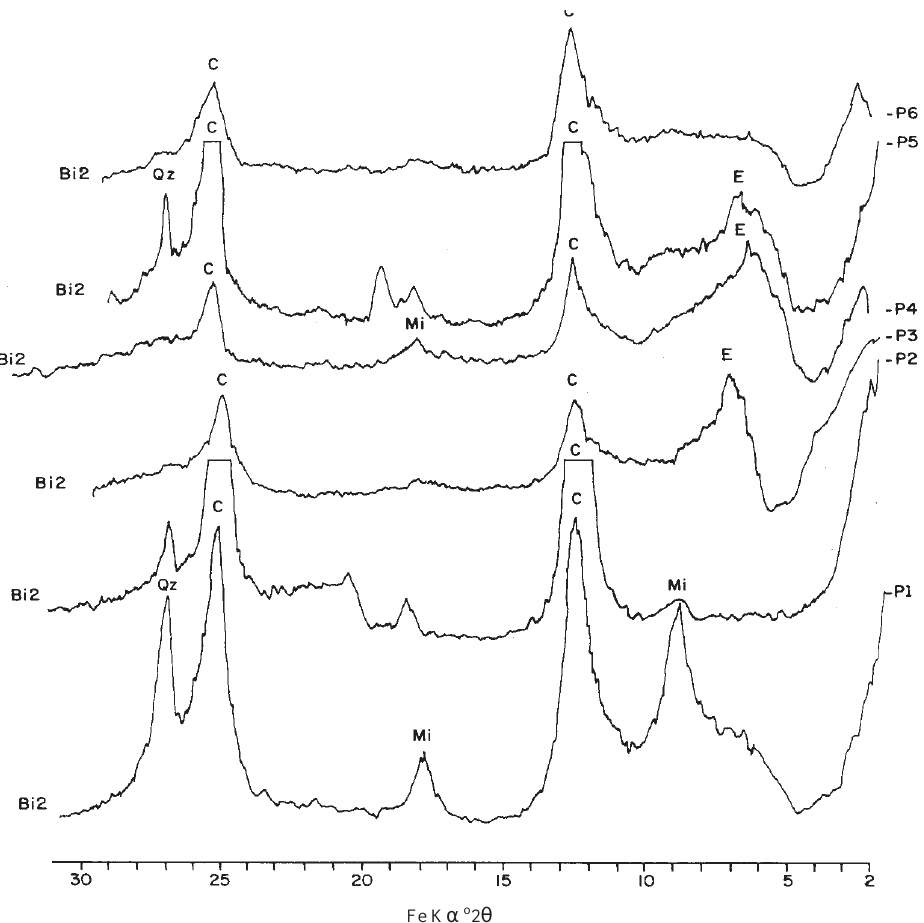
Figura 2. Difratograma de raio-X da fração argila, analisada em estado natural, de horizontes diagnósticos dos perfis P1, P2, P3, P4, P5 e P6. C: caulinita; Mi: mica; Qz: quartzo; E: